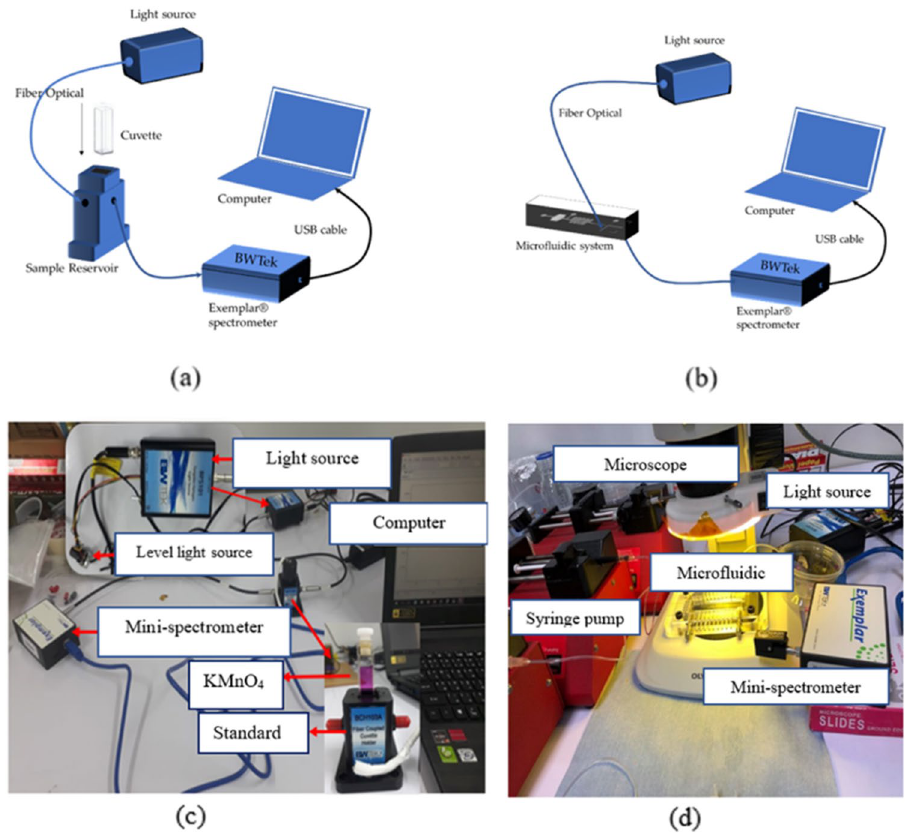
Figure 2. System used to obtain the fluorescence spectra. Analysis of milk under ( a ) standard system ( b ) microfluidic chip ( c ) experimental setup for sorting somatic cells under standard device (cuvette) and ( d ) experimental setup for sorting somatic cells under microfluidic